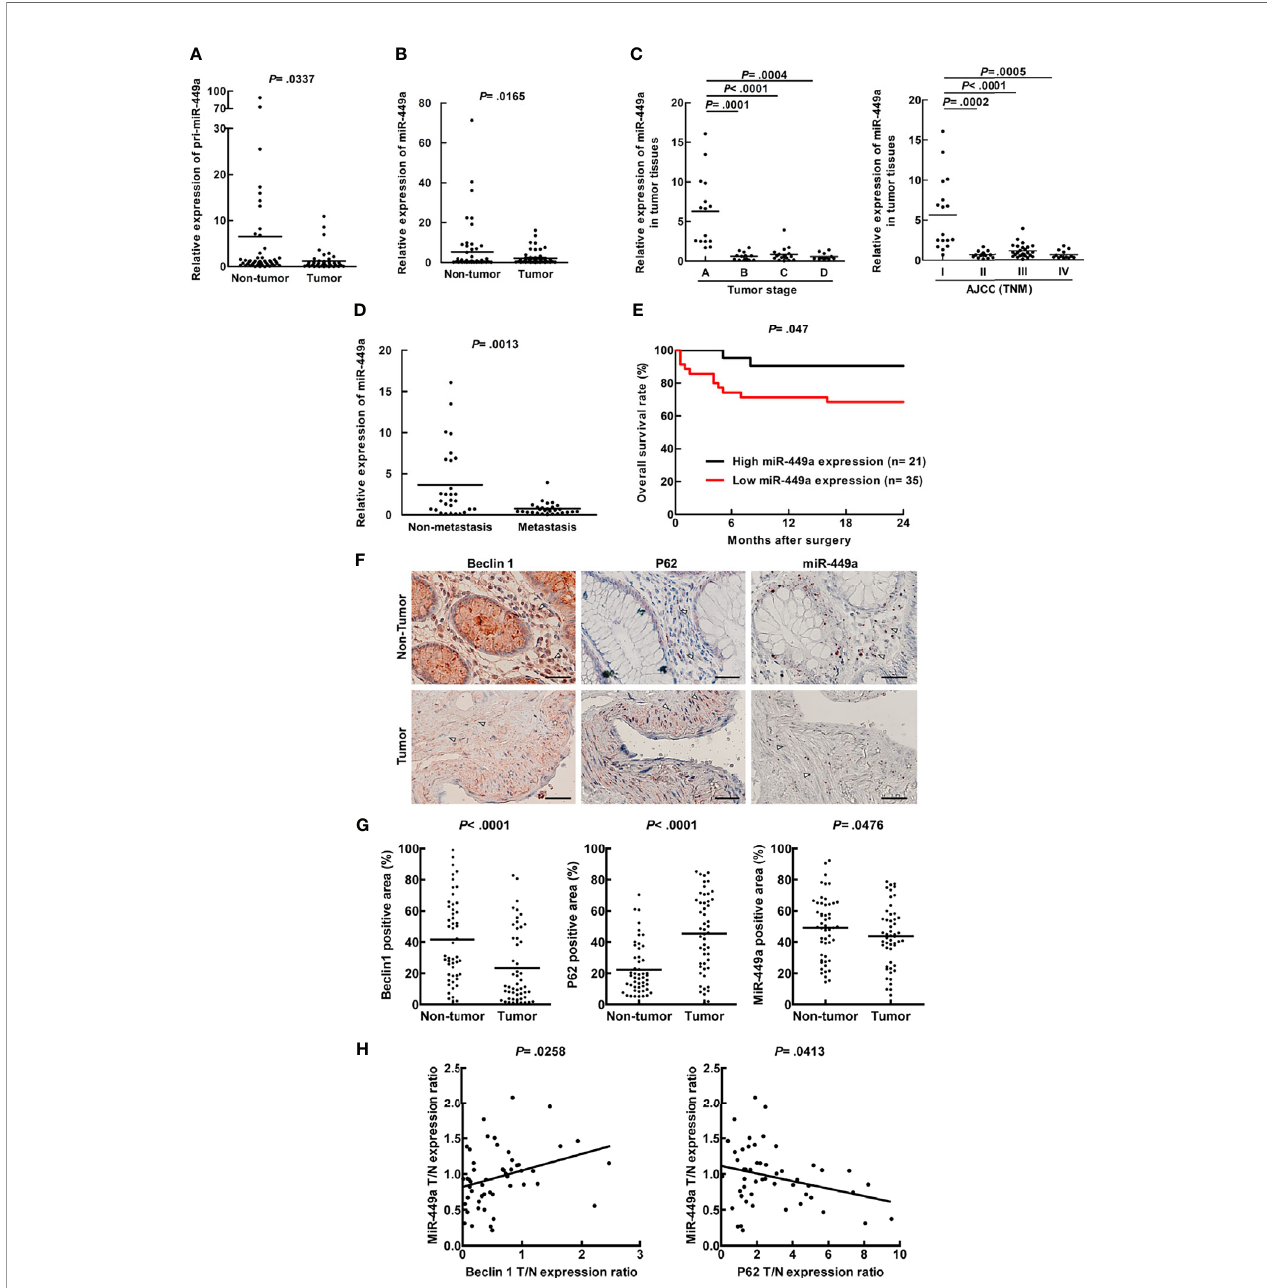
FIGURE 1 | Low expression of miR-449a associated with low autophagic activity was detected in tumors of CRC patient specimens. Real-time PCR was used to analyze the human CRC patient specimens for miR-449a expression levels. (A) The expression level of primary miR-449a in 56 paired CRC patient specimens (tumors and adjacent non-tumor parts). (B) The expression level of mature miR-449a in above CRC patient specimens. (C) The expression of miR-449a in 56 CRC patient specimens grouped by Duke Stages. (D) The expression of miR-449a in 56 CRC patient specimens grouped as non-metastasis and metastasis. (E) The overall survival rate of CRC patients within 2 years after surgery was generated by Kaplan-Meier survival analysis followed by log-rank test to obtain the p-value. These 56 paired CRC patients were divided into two groups. High miR-449a expression group (n = 21) represents miR-449a expression in the tumor tissue/miR-449a expression in the adjacent non-tumor tissue > 1-fold. Low-miR-449a expression group (n=35) represents miR-449a expression in the tumor tissue/miR-449a expression in the adjacent non-tumor tissue ≤ 1-fold. (F) The representative sections from 51 paired CRC specimens in the tissue array showing the expression levels of Beclin 1, p62, and miR- 449a. MiR-449a level was shown by in situ hybridization labeling miRNA. Scale bar= 50 m m. △ represents the stromal area and ☆ represents the tumor area. (G) Beclin 1, p62, and miR-449a levels were quanti fi ed by de fi ning regions of interest (ROIs) using automated cell acquisition and quanti fi cation software (Histoquest). (H) Correlation of miR-449a expression with Beclin 1 and p62 was analyzed from the 51 paired CRC specimens in the tissue array and linear regression coef fi cient and statistical signi fi cance are